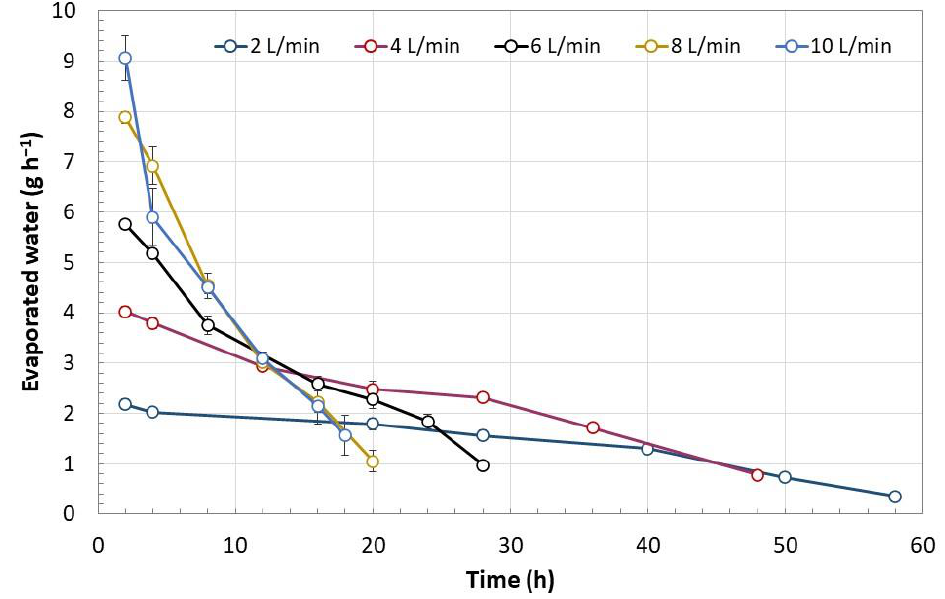
Figure 7. Drying speed of the biomass immobilized in calcium alginate as a function of the time required to reach a residual humidity of 20%. Error bars represent the standard deviation of two determinations. Two-way ANOVA (Tukey’s test for an α < 0.5) (F = 1.83; df = 2; p = 0.177).